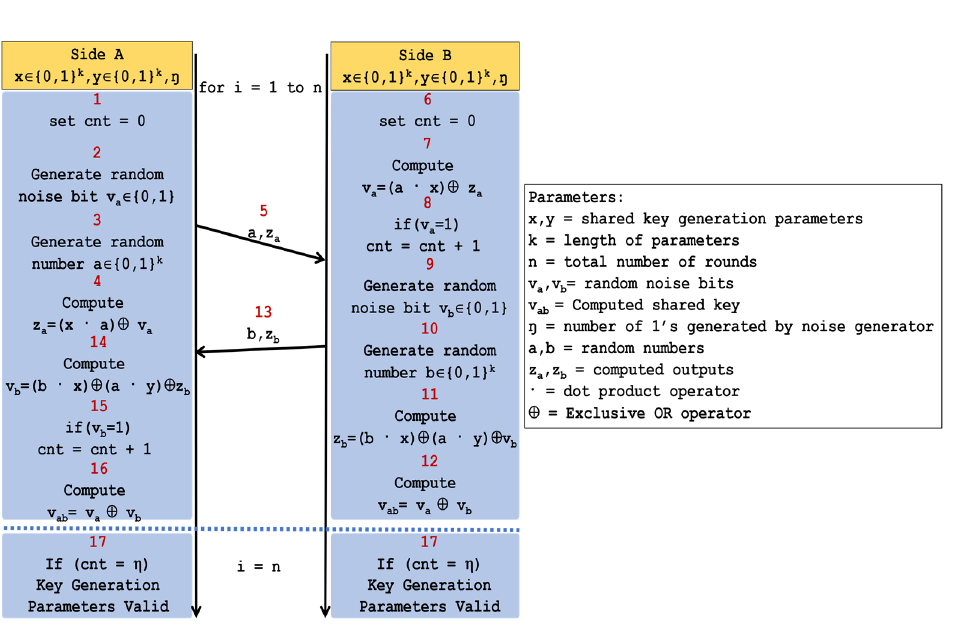
Figure 3. Algorithm flow of the lightweight key exchange protocol.